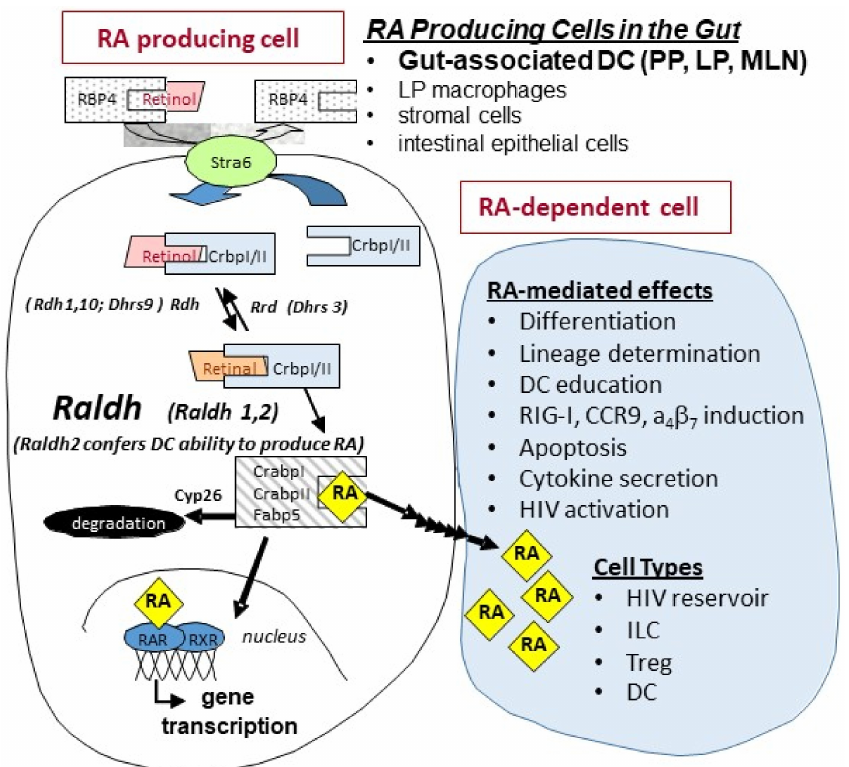
Figure 1. Retinoid metabolism and RA signaling . Studies in mice and humans have indicated that major cellular sources of all-trans retinoic acid (RA) production in the intestine are dendritic cells (DCs) from mesenteric lymph nodes (MLN), Peyer’s patches (PP), and small intestine lamina propria (LP); intestinal epithelial cells; and macrophages [1,2,12]. Raldh2 expression is restricted to limited cell types and is the critical regulatory element in immune cell populations that confers cells the ability to synthesize RA. Once formed, RA can be: (1) transported to the nucleus of the RA-producing cell (e.g., dendritic cells in the gut) where it binds to nuclear receptors and initiates gene transcription, (2) transported to neighboring cells (e.g., T-cells and ILCs) to initiate RA-mediated signaling, and/or (3) degraded by